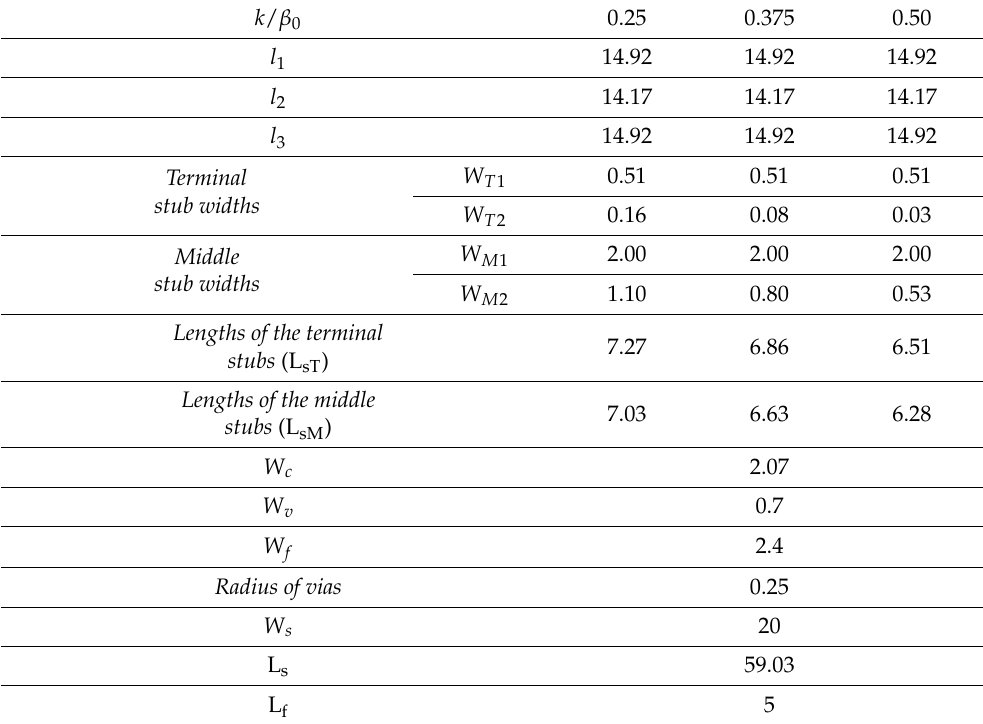
Figure 8. Simulated S − parameters results of the lumped element filter represented in Figure 7.